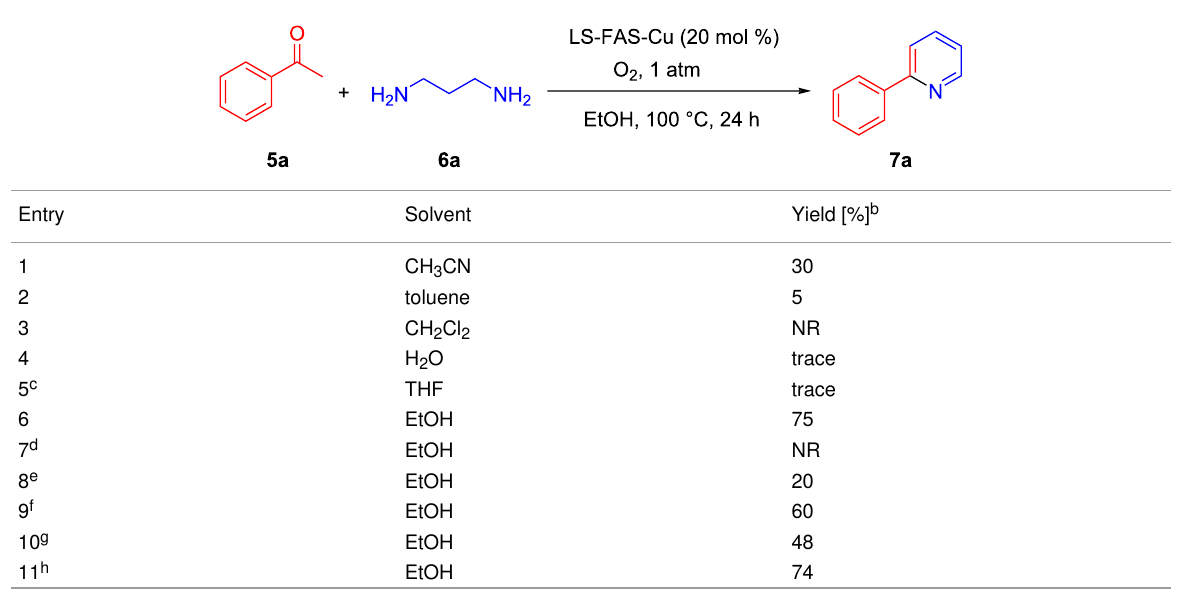
Table 2: Optimizing the reaction condition of acetophenones and 1,3-diaminopropane to synthesis 2 ‑ arylpyridine derivatives. a